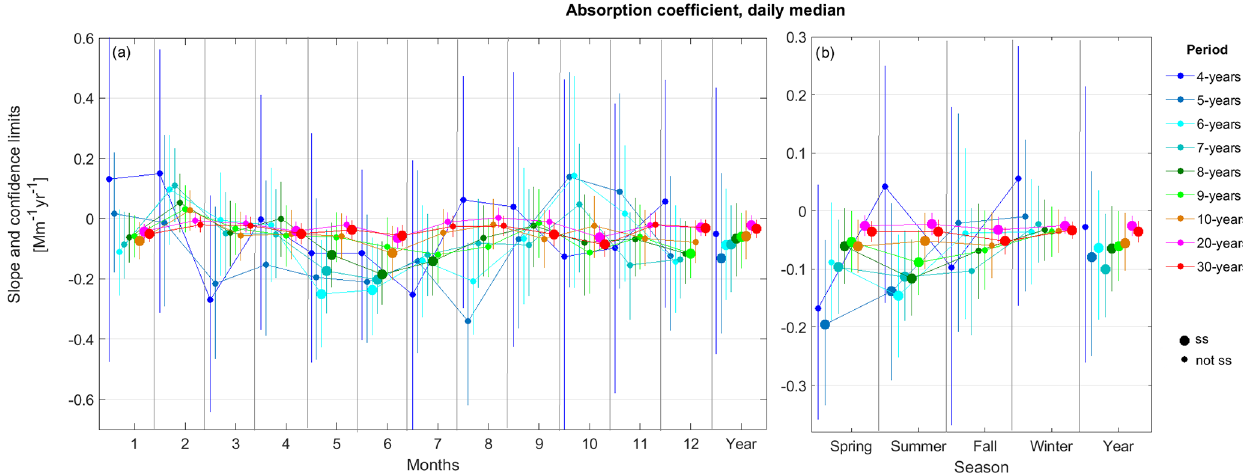
Figure 10. VCTFPW slopes (dots) and CLs (vertical lines) as a function of various periods ending in 2018 for the daily aerosol absorption coefficient for the division of the time series into (a) 12 months and (b) four meteorological seasons. Colors represent time period lengths and bigger symbols represent ss trends with the 3PW method.